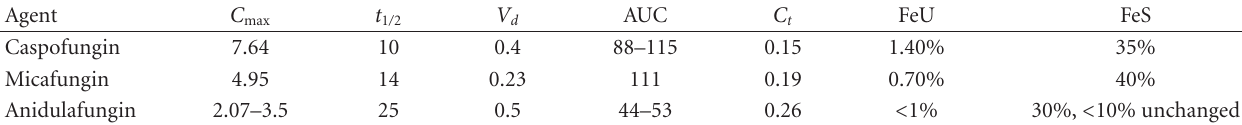
Table 5: Pharmacokinetic parameters of the major echinocandins in clinical use ∗ .